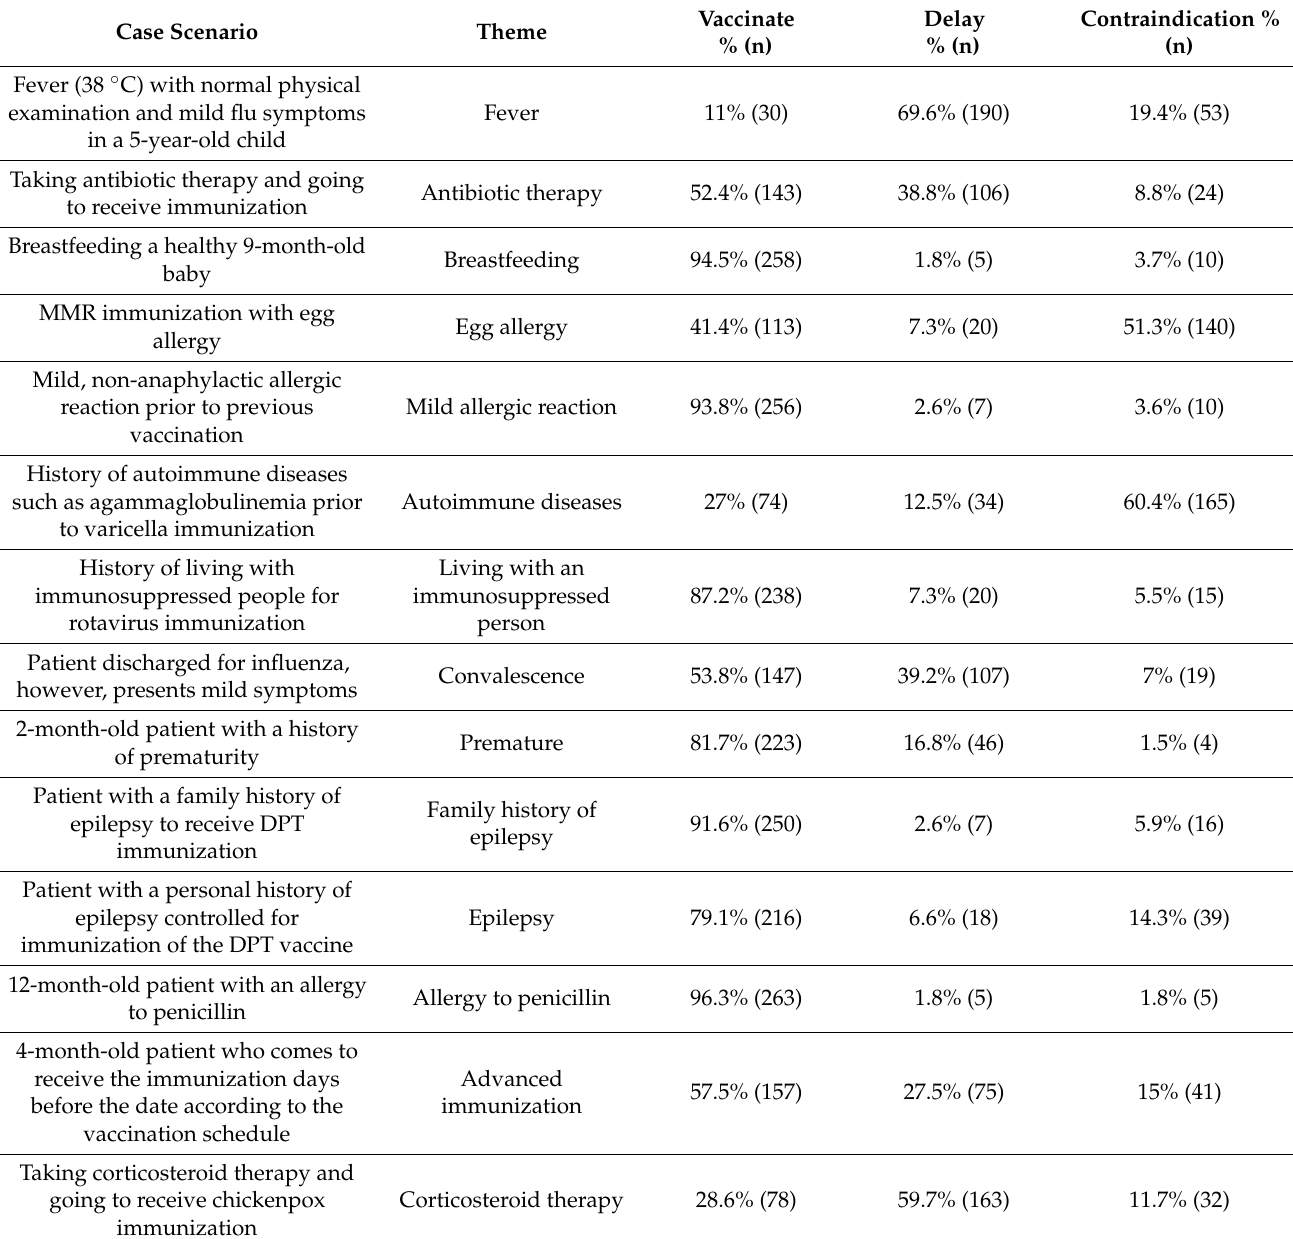
Table 2. Summary of responses from health